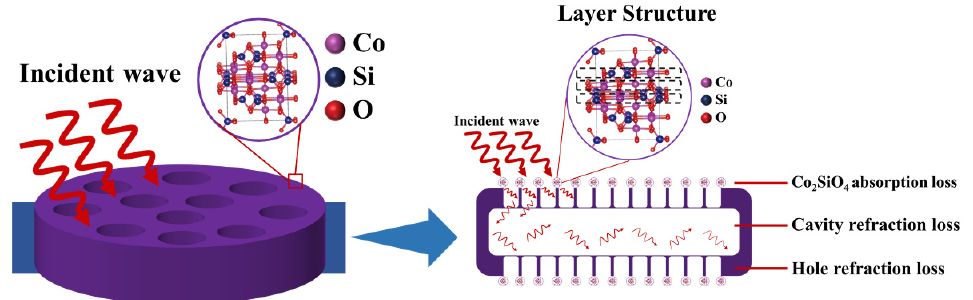
Figure 6. Wave absorption mechanism of Co 2 SiO 4 @DE composite